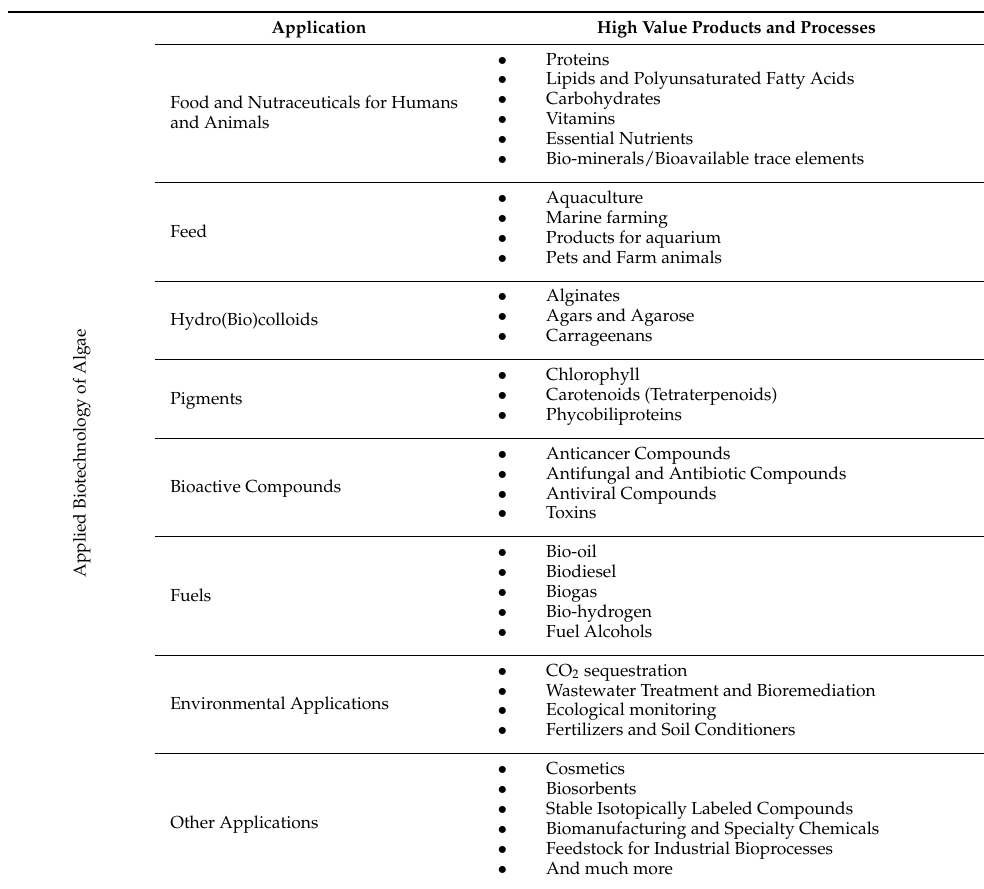
Table 1. Main applications of algae in